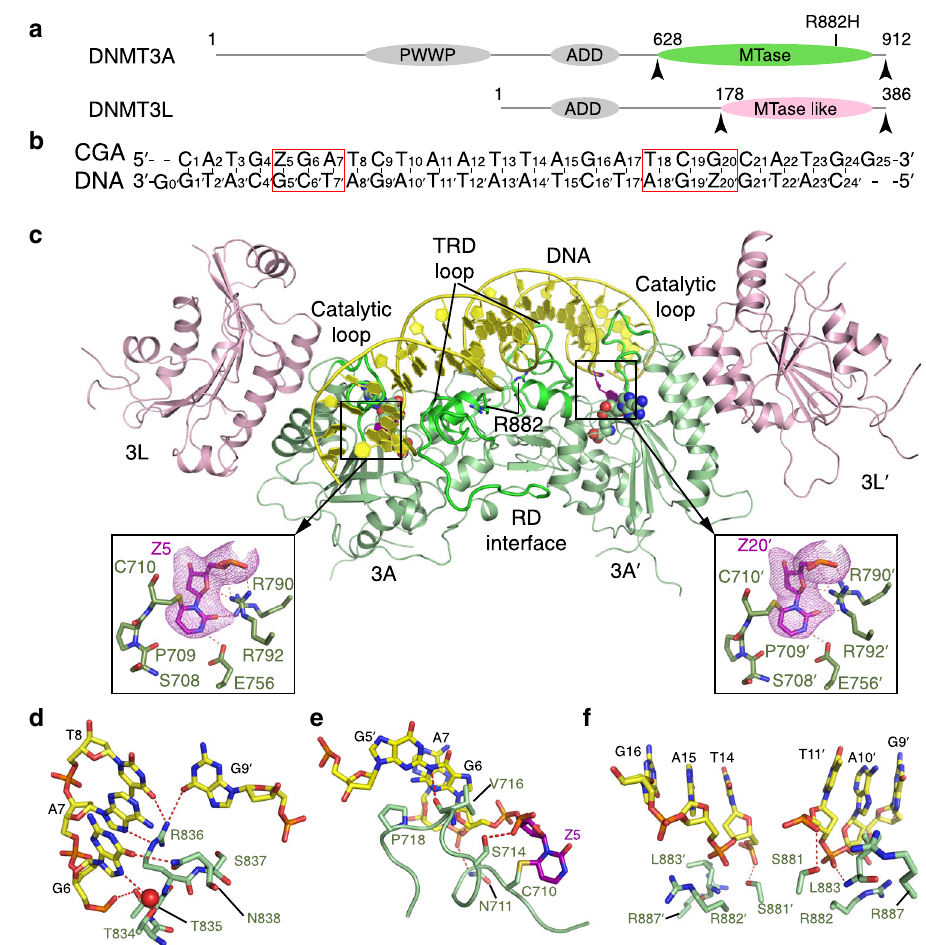
Fig. 1 Structure of the DNMT3A WT – DNMT3L tetramer in complex with CGA DNA. a Domain architecture of DNMT3A and DNMT3L with the C-terminal domains marked with arrowheads. The site for R882H mutation is marked. b DNA sequence (CGA) used for the structural study. Z, zebularine. c Ribbon representations of DNMT3A WT – DNMT3L bound to CGA DNA and SAH, with residue R882 marked. The zebularines anchored at the two active sites are shown in expanded views, with hydrogen-bonding interactions depicted as dashed lines and Fo – Fc omit map (violet) contoured at 2.0 sigma level. The SAH molecules are shown in sphere representation. d – f Close-up views of the DNA interactions of the TRD loop ( d ), catalytic loop ( e ) and RD interface ( f ) of DNMT3A WT